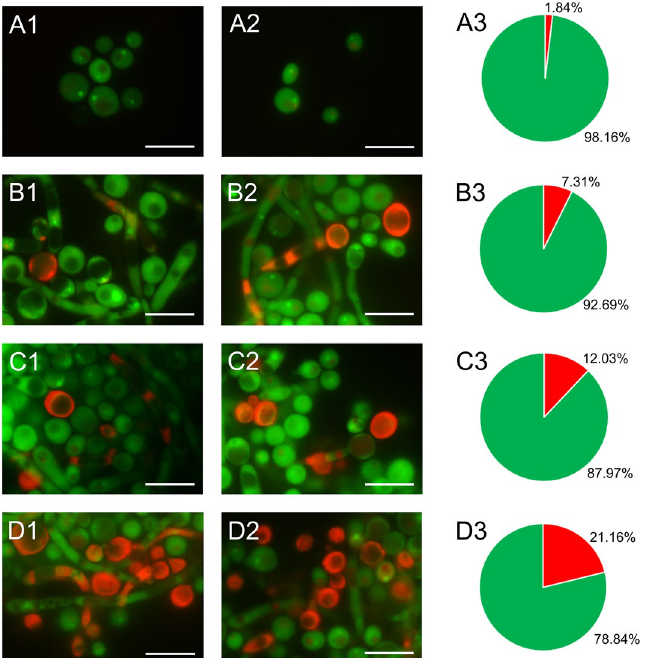
Figure 1. C. albicans cells after staining with acridine orange: ( A1 , A2 ) control cells, ( B1 , B2 ) cells treated with AAF at the concentration of 25 µg mL −1 , ( C1 , C2 ) at the concentration 50 µg mL −1 , ( D1 , D2 ) at the concentration 100 µg mL −1 . AO intercalates with DNA and RNA, and the acidic cellular compartments glow orange. The number of cells with the intense orange color increased with the increasing concentration of AAF as shown in diagrams ( A3 , B3 , C3 , and D3 ) in this figure. Bars represent 2 µm.